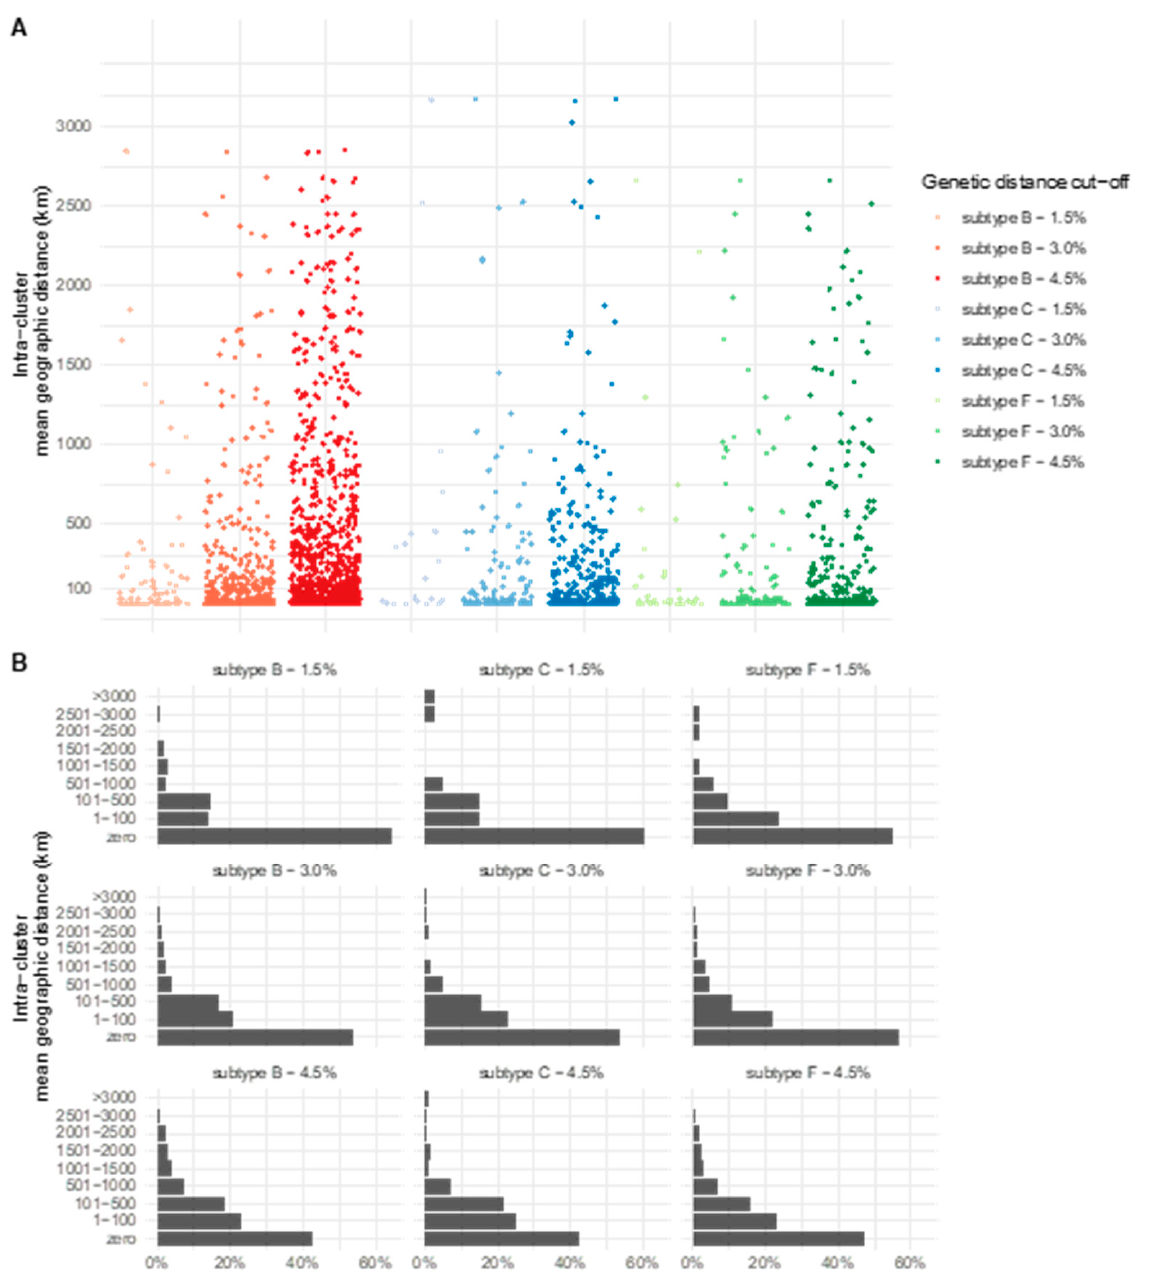
Figure 3. Intra-cluster mean geographic distance for subtypes B, C and F1 in different genetic distance cut-offs. ( A ) Scatter plots showing all clusters identified in each analysis and vertically positioned according to the mean intra-cluster geographic distance (Y-axis). ( B ) Histogram showing the frequency of clusters for categorical groups of mean intra-cluster geographic distances. Zero means that all individuals live in the same municipality.